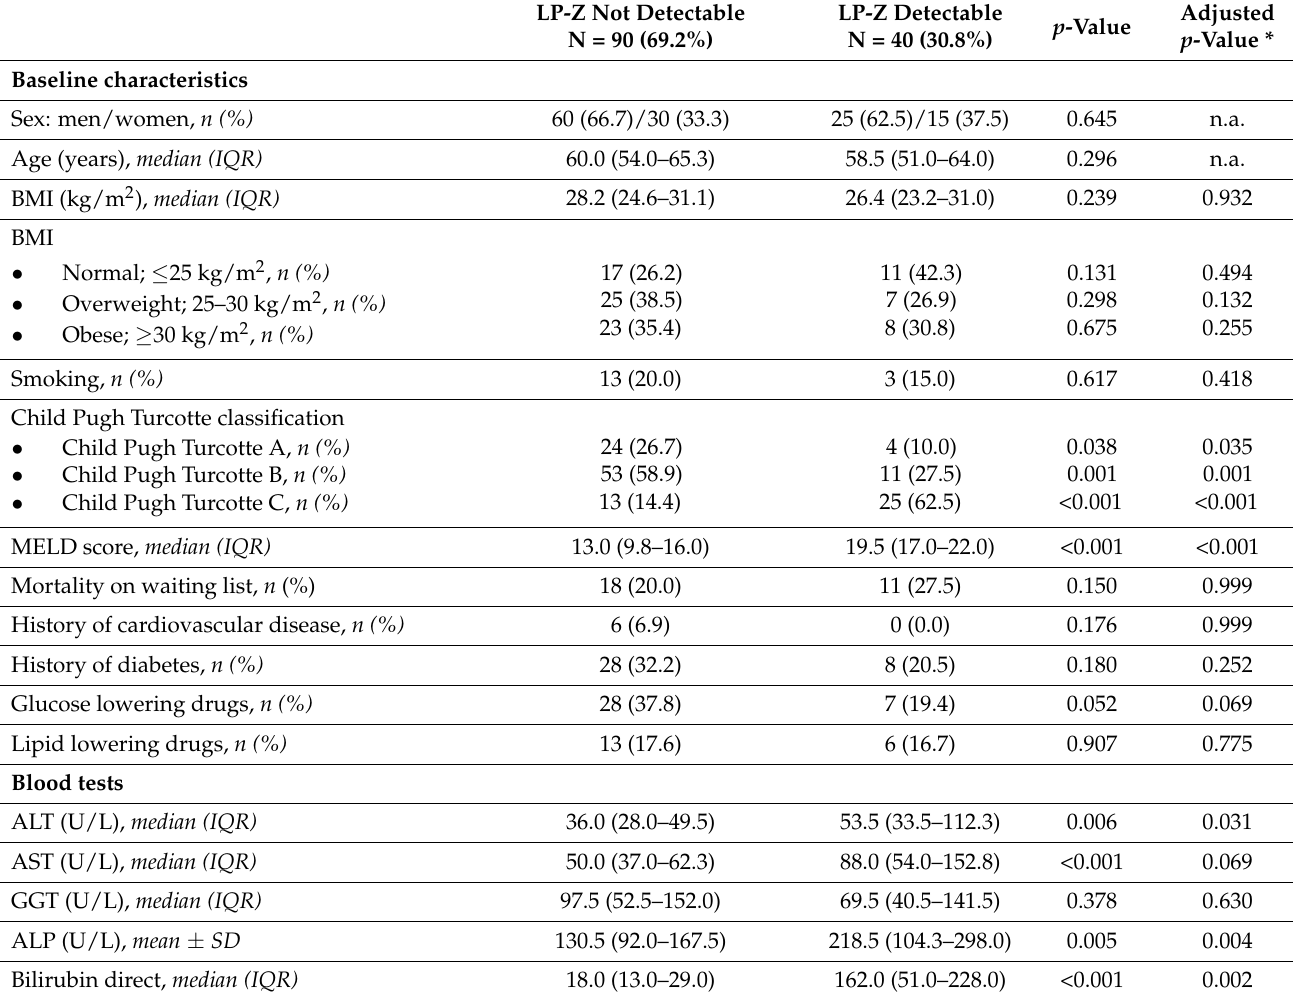
Table 3. Clinical and biochemical characteristics of LP-Z in 130 pre-transplant cirrhotic patients from TransplantLines. LP-Z Not Detectable LP-Z Detectable N = 90 (69.2%) N = 40